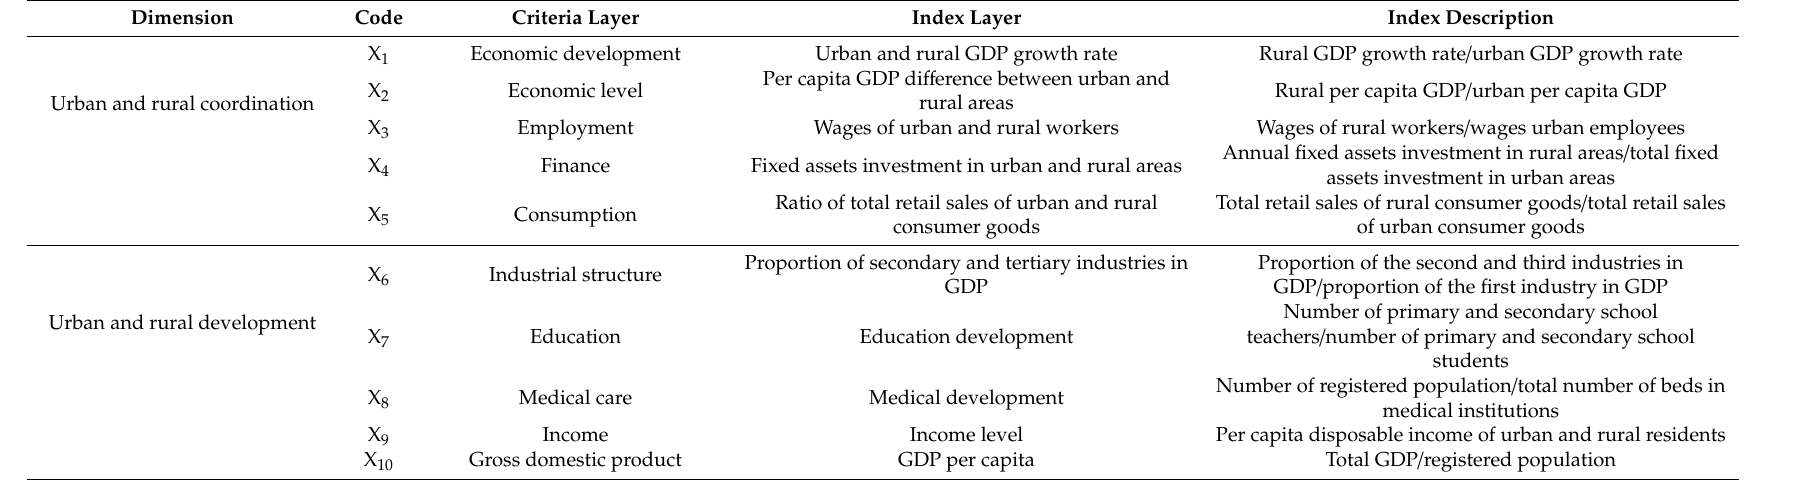
Table 1. Indicator system of urban and rural coordination